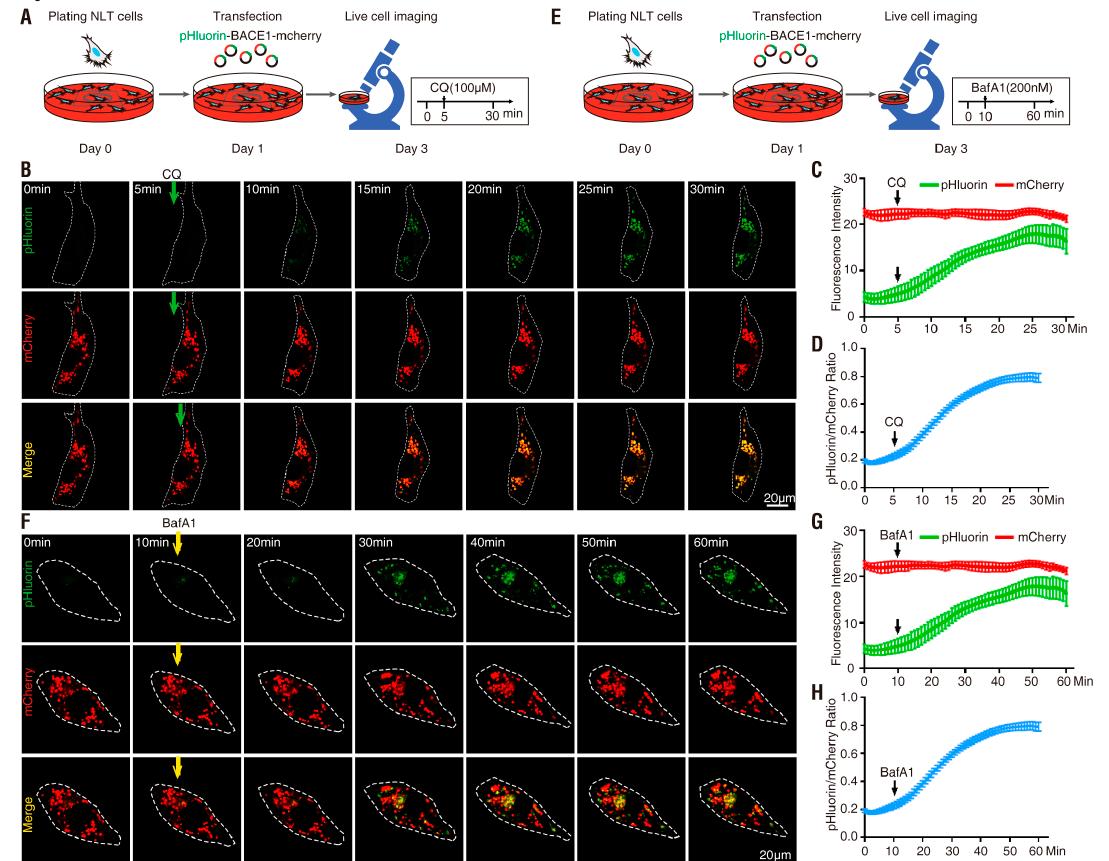
Figure 3. Response of NLT cells expressing pHluorin ‐ BACE1 ‐ mCherry to CQ and BafA1 treatment ( A ) Schematics of live cell imaging experimental procedures. NLT cells were plated on Day 0 and co ‐ transfected with pHluorin ‐ BACE1 ‐ mCherry and BFP on Day 1. NLT cells expressing BACE1 ‐ mCherry ‐ pHluorin were imaged every minute for 30 min on Day 3 and treated with 100 µM CQ after 5 min. ( B ) Representative images from live cell imaging in response to CQ. NLT cells expressing pHluorin ‐ BACE1 ‐ mCherry (red and green) were outlined according to BFP expression. Scale bar, 20 µm. ( C ) The fluorescence signal intensity of mCherry (red) and pHluorin (green) in the outlined area was measured using ImageJ and plotted along with time in response to CQ. Data were shown as mean ± SEM ( n > 15 cells from three independent experiments). ( D ) Quantification analysis of the pHluorin/mCherry ratio from C. Data was shown as mean ± SEM ( n > 15 cells from three independent experiments). ( E ) Schematics of live cell imaging experimental procedures. NLT cells were plated on Day 0 and co ‐ transfected with pHluorin ‐ BACE1 ‐ mCherry and BFP on Day 1. NLT cells expressing pHluorin ‐ BACE1 ‐ mCherry were imaged every minute for 60 min on Day 3 and treated with 200 nM BafA1 after 10 min. ( F ) Representative images from live cell imaging in response to BafA1. NLT cells expressing pHluorin ‐ BACE1 ‐ mCherry (red and green) were outlined according to BFP expression. Scale bar, 20 µ m. ( G ) The fluorescence signal intensity of mCherry (red) and pHluorin (green) in the outlined area was measured and plotted over time in response to BafA1. Data were shown as mean ± SEM ( n > 15 cells from three independent experiments). ( H ) Quantification analysis of the pHluorin / mCherry ratio from ( G ). Data was shown as mean ± SEM ( n > 15 cells from three independent